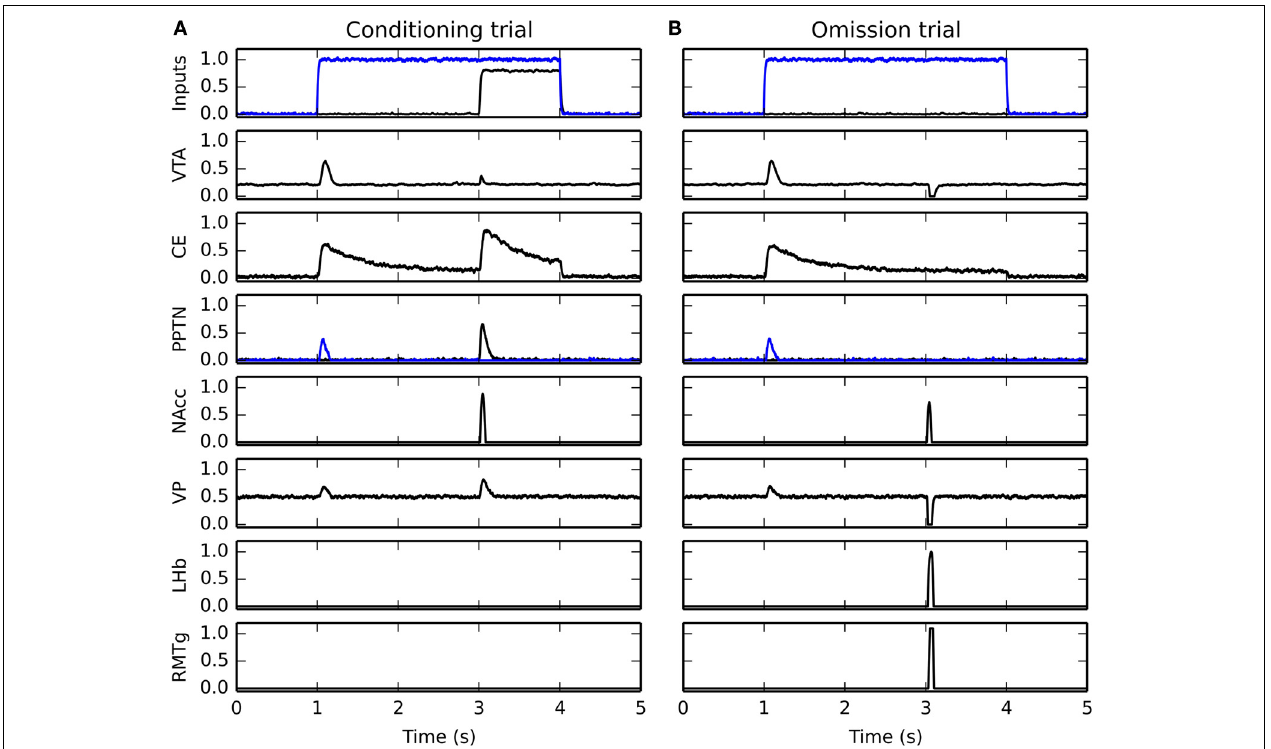
FIGURE 10 | Timecourse of activity in different areas of the model. Panel (A) shows the activity during the last conditioning trial of the CS1-US1 association, while panel (B) shows what happen during reward omission after learning (CS1 alone). The first row shows the inputs to the network, with the blue line showing the mean activity in the IT cluster corresponding to CS1, while the black line shows the mean activity for the neurons of LH representing US1. The second row shows the timecourse of the VTA cell during these trials, similar to what is shown on Figure 5 .